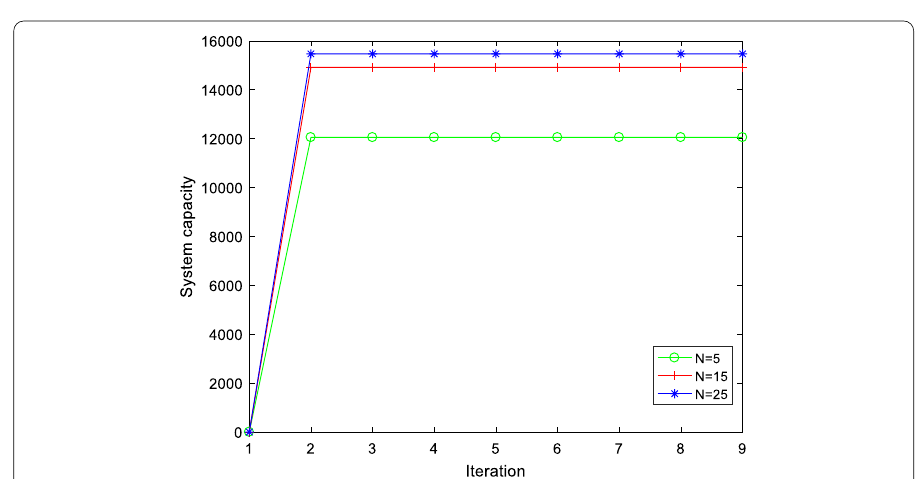
Fig. 6 Comparison of system capacity. We set the number of base stations to 5, 15 and 25, respectively. With the increase in the number of base stations, the total capacity of the system based on the proposed